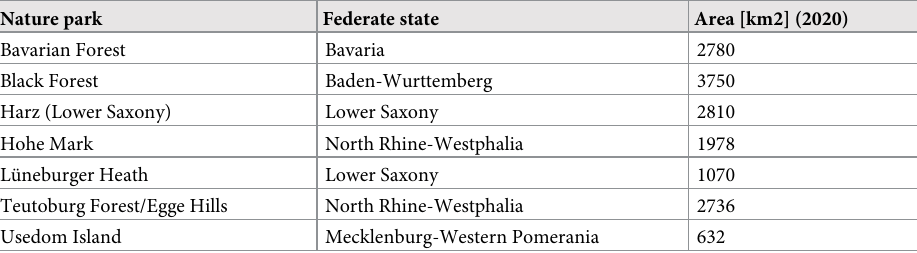
Table 1. Overview of sampled nature parks. Area figures as reported on the website Naturparke.de